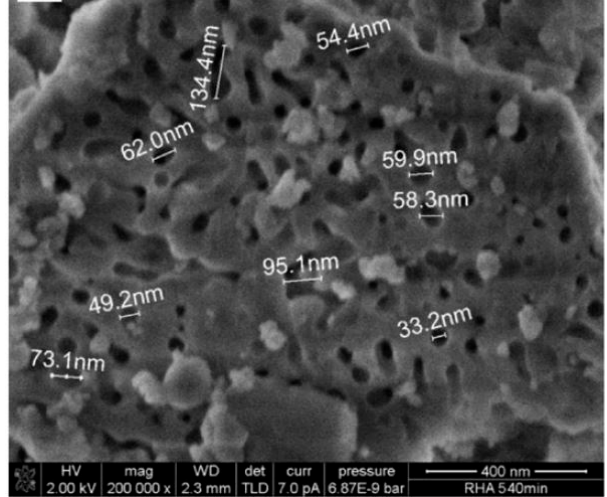
Figure 4. SEM images of microstructure of rice husk ash showing its porous microstructure [51].